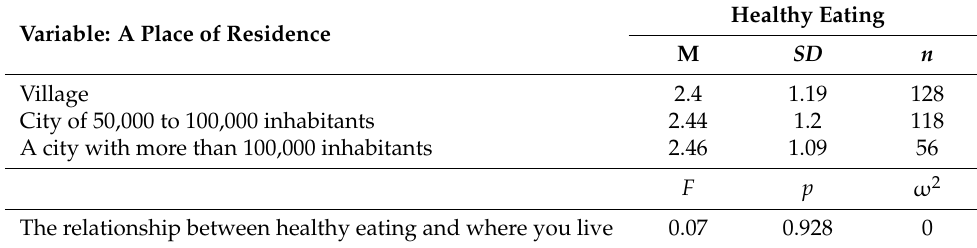
Table 4. Relationship of healthy eating to a place of residence. Variable: A Place of Residence